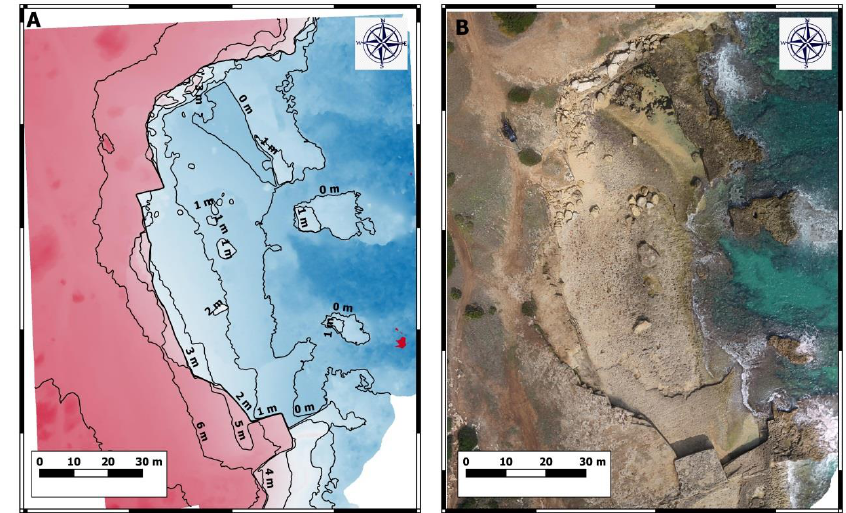
Figure 5. ( A ) High-resolution digital elevation model (2 cm grid cell). ( B ) Orthophotographs (resolution 1 cm/pxl) reconstructed by UAV photogrammetric survey.